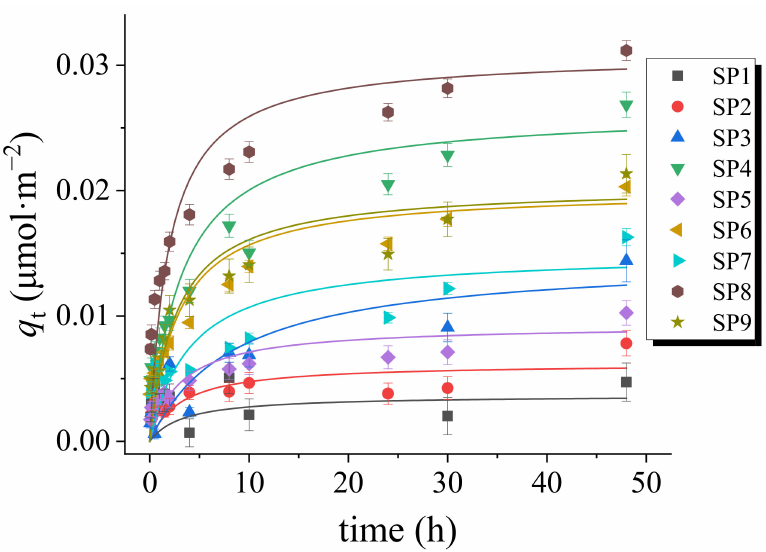
Figure 6. Adsorption kinetics of ASA on the collected actual soil. Solid points are experimental data, and curves are fitted results by pseudo-second-order kinetic model. ASA = 20 µ M, NaCl = 10 mM, and soil dosage = 5 g · L − 1 . Table 3. Fitted parameters for ASA adsorption of soil by a pseudo-second order kinetic model.